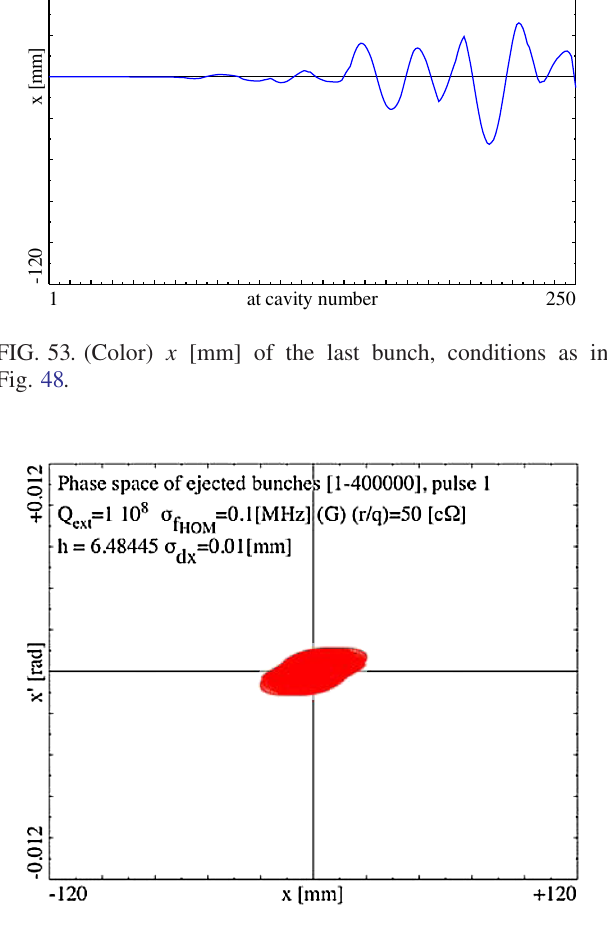
FIG. 54. (Color) Transverse phase-space image of the ejected bunches, conditions as in Fig. 48, but for the 1st pulse.